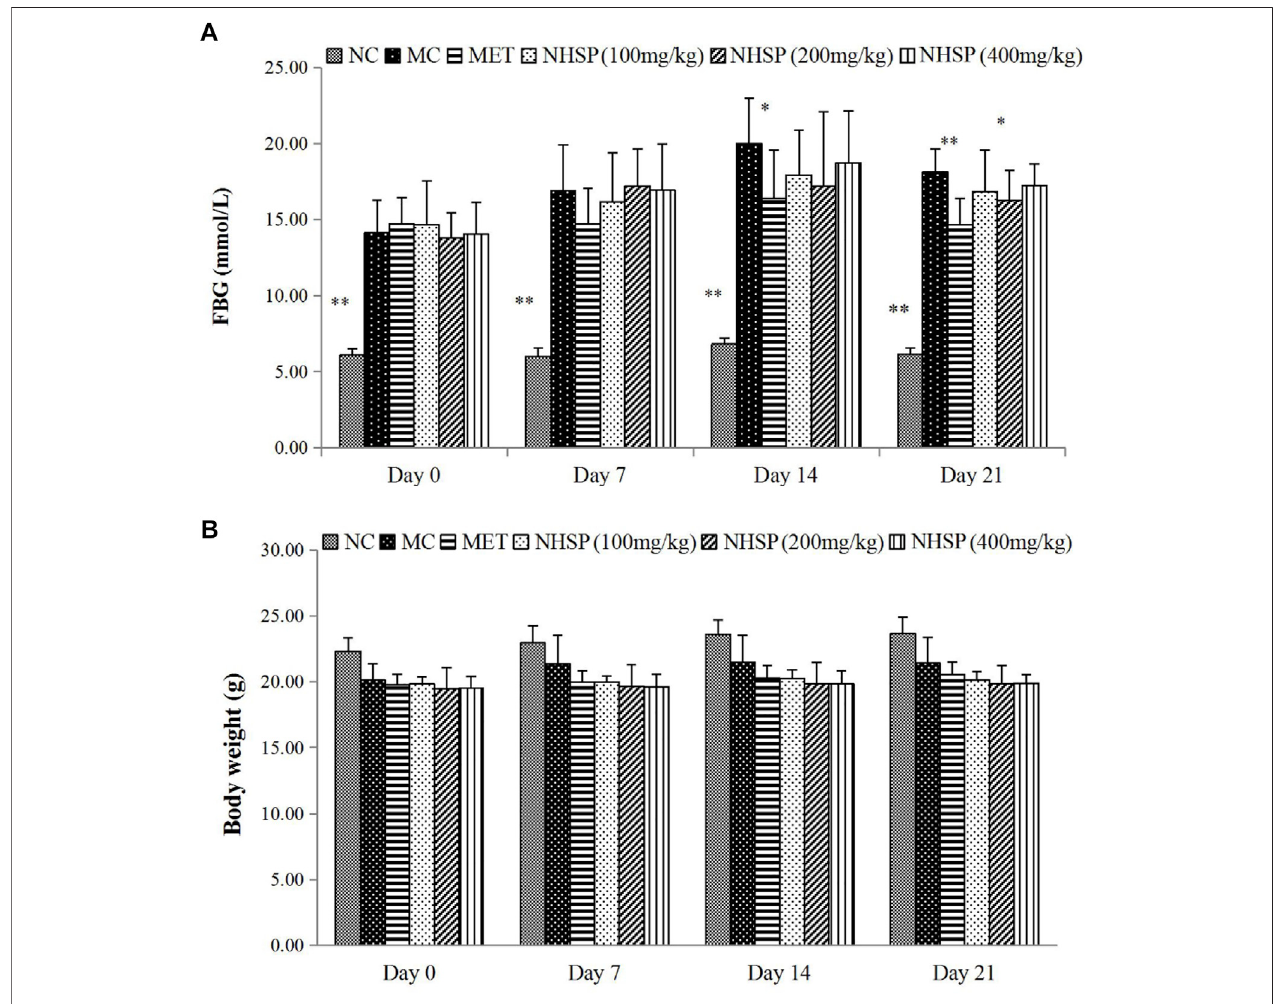
FIGURE 6 | Effects of NHSP treatment on a type 2 diabetic mouse model. (A) Effect of NHSP on weight. (B) Effect of NHSP on FBG. Values are presented as mean ± S.D. * p < 0.05 for comparison with MC group. ** p < 0.01 for comparison with MC group.